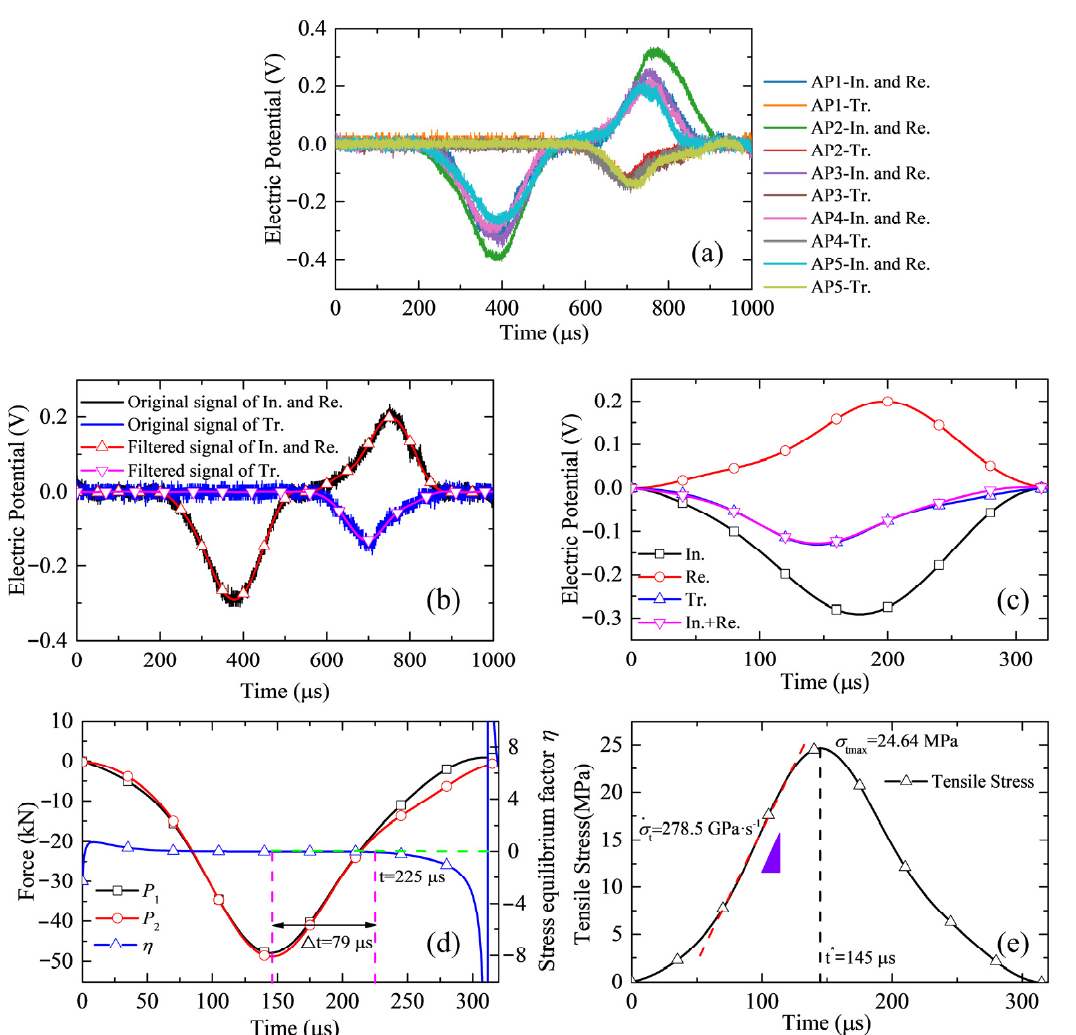
Figure 4. Experimental results for the Andesite specimen. ( a ) Raw signals of the Brazilian test. ( b ) Raw and filtered signal at a striking velocity of 4.88 m/s. ( c ) The incident (In.), reflected (Re.), transmitted (Tr.), and superposed (In. + Re.) waves. ( d ) Verified stress equilibrium. ( e ) Determination of dynamic tensile strength and loading